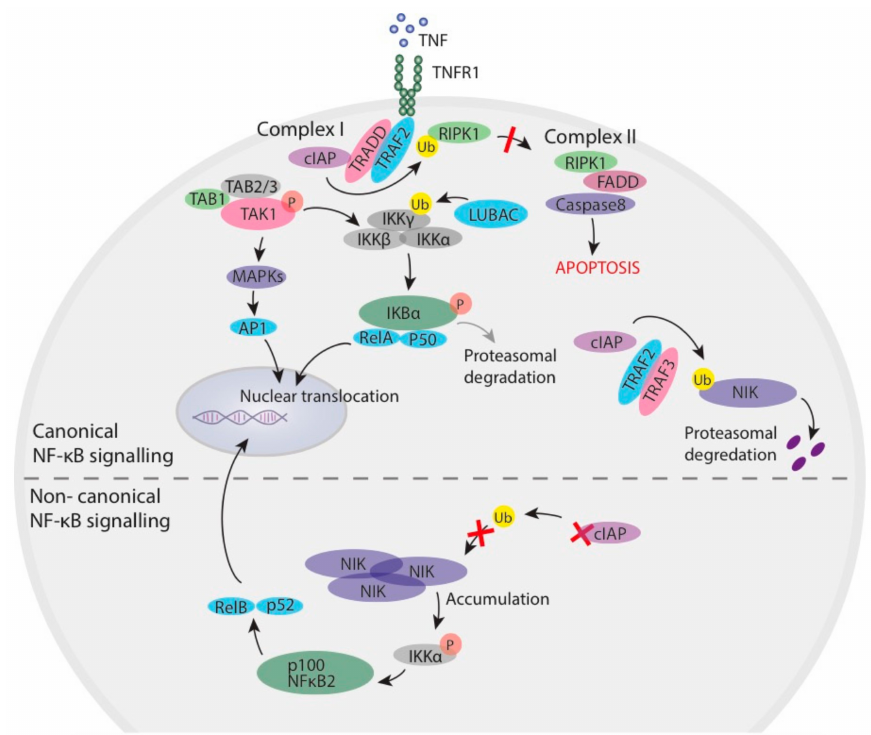
Figure 1. The Inhibitor of Apoptosis Proteins (IAPs) are critical regulators of both canonical and non-canonical NF- κ B signalling. During canonical NF- κ B signalling, the ubiquitylation of Complex